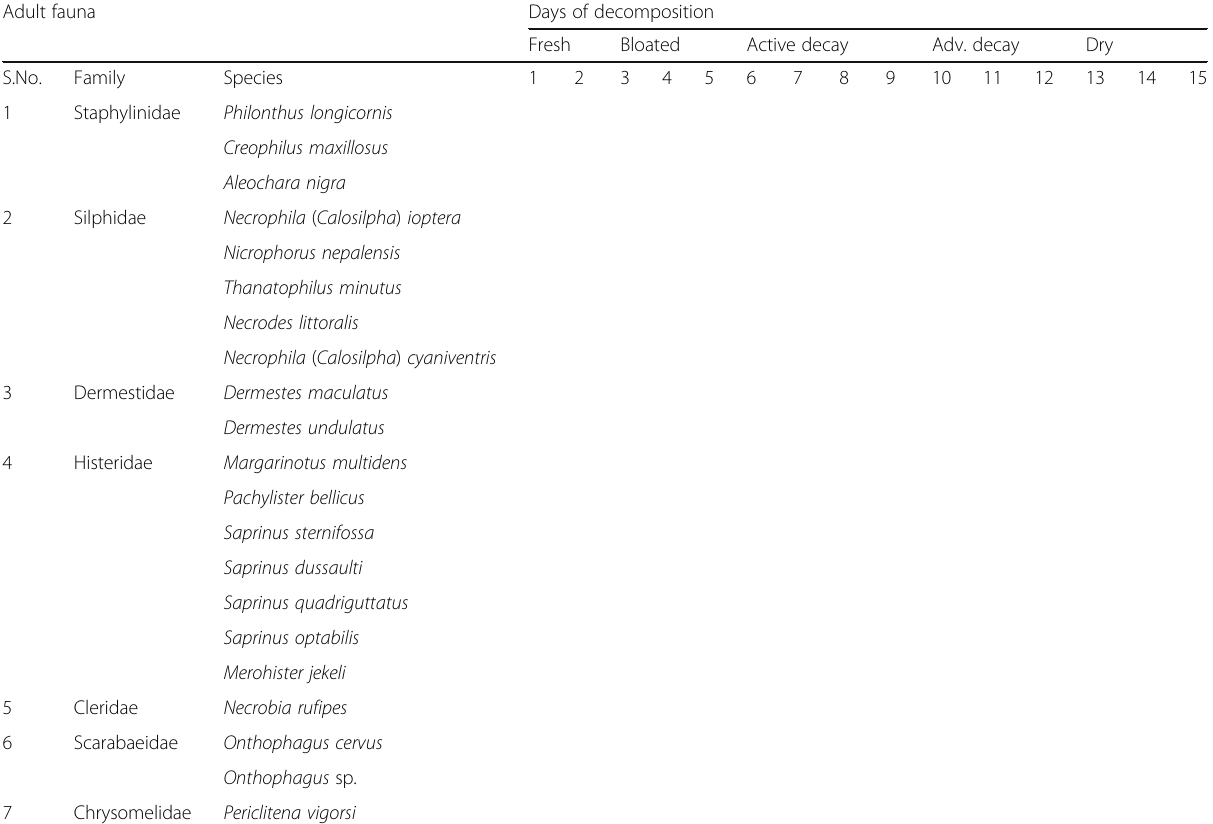
Table 2 Chronological sequence of beetle occurrence during different decomposition stages Adult fauna